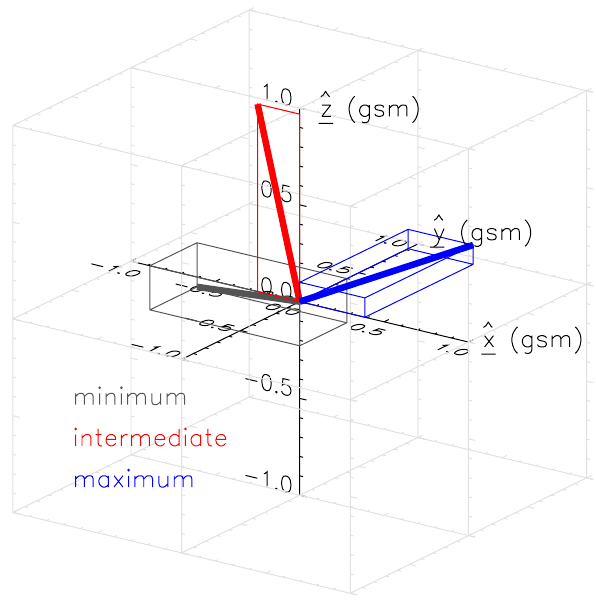
Fig. 11. The variance system in GSM unit space from Cluster 1 for the 13 August event in the same format as Fig.